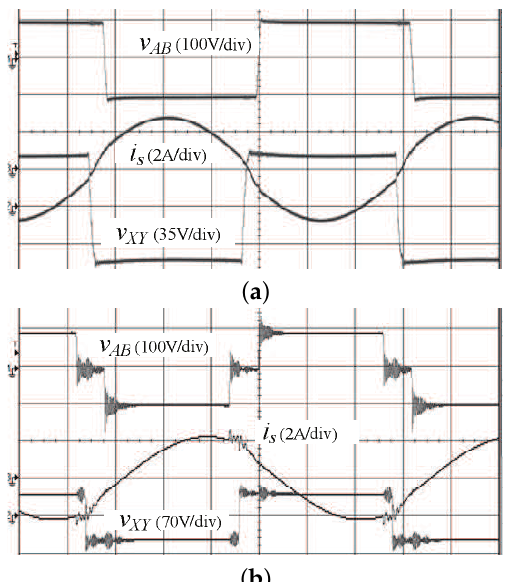
Figure 13. Experimental plots at V L = 48 V, output power: ( a ) P o = − 200 W; ( b ) P o = − 100 W. Time scale: 1.52 µ s/div.